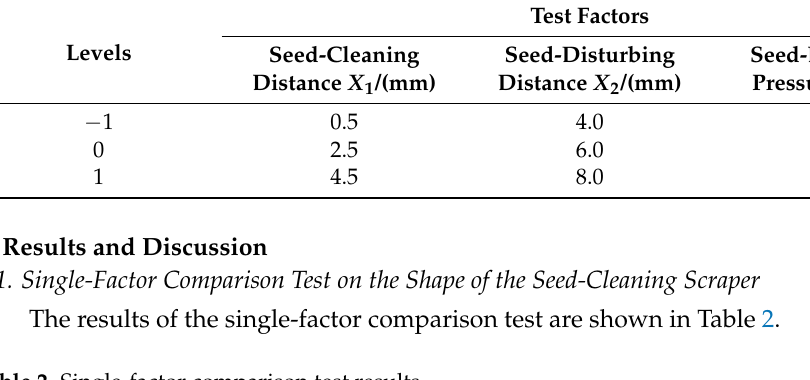
Table 2. Single-factor comparison test